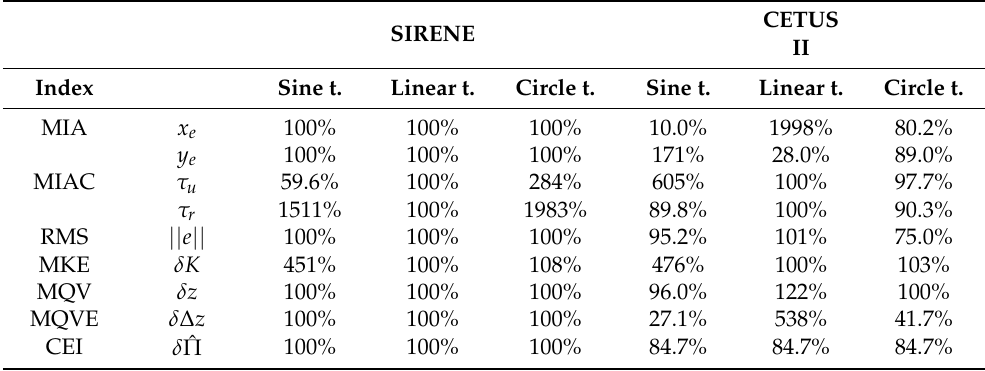
Table 3. Relative performance for the SIRENE and CETUS II and for different trajectories.